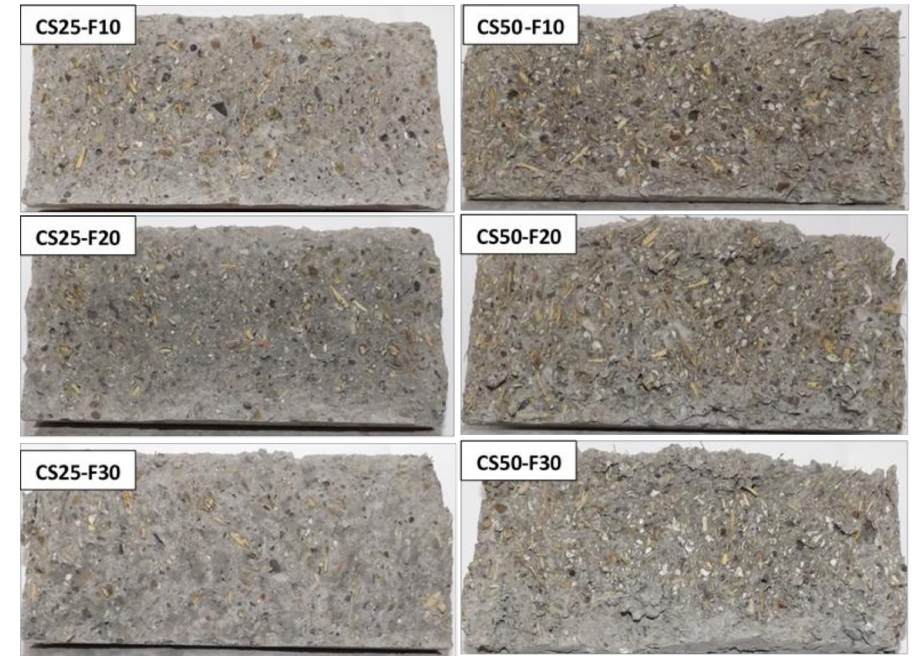
Figure 17. The cylinder’s section of CS-F group of composites, after splitting tensile